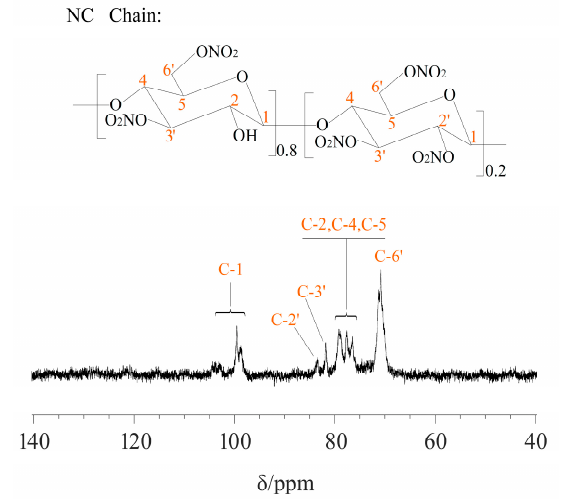
Figure 5. 13 C NMR spectra of NC.